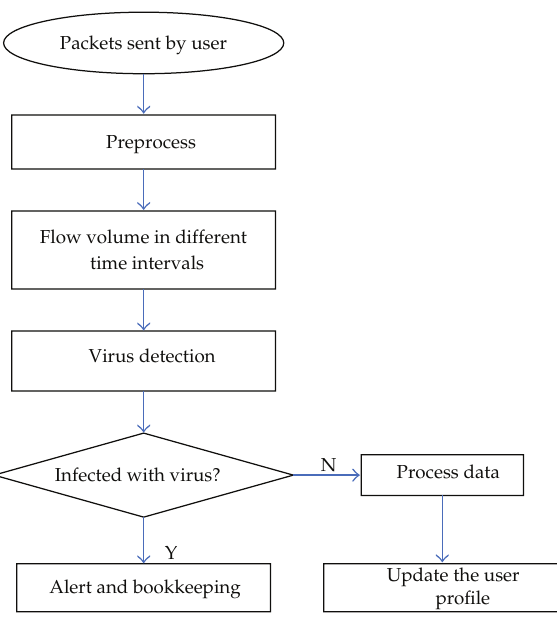
Figure 1: Model flow